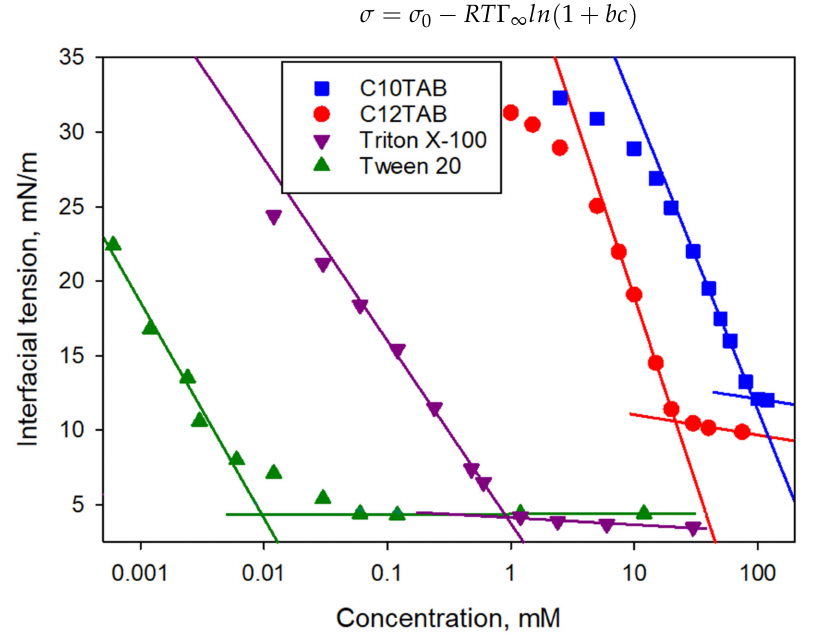
Figure 5. Concentration dependence of interfacial tension between solutions of surfactants in the glycerol/water mixture and the silicone